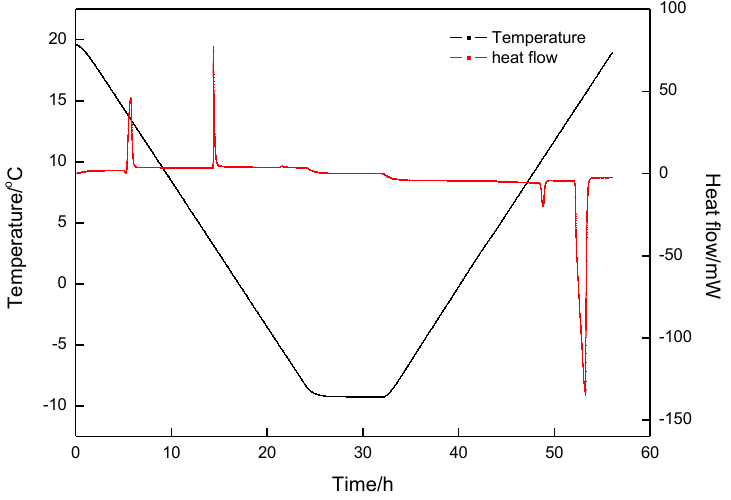
Figure 8. Heat flow and temperature curve at 20.0~ −8.8 °C and 5.0